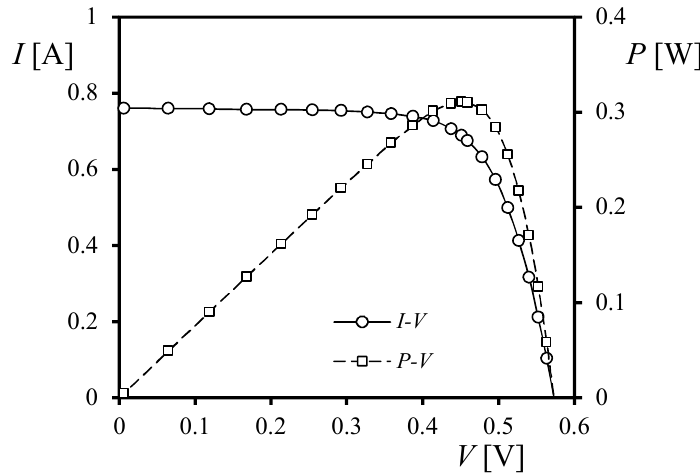
Figure 2. Current–voltage ( I – V ) and power–voltage ( P – V ) curves of an RTC France Si solar cell [2].